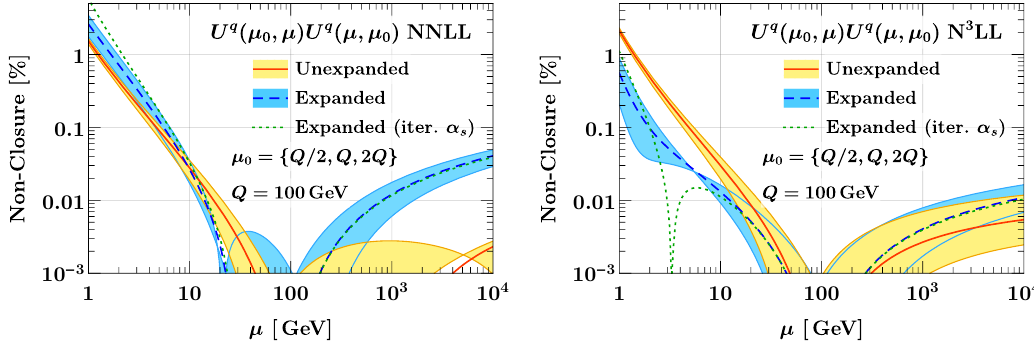
Figure 6 . Deviation from the closure condition U q ( (cid:22) 0 ; (cid:22) ) U q ( (cid:22); (cid:22) 0 ) = 1 at NNLL (left) and N 3 LL (right) for the unexpanded method (solid) and expanded method (dashed). The central lines are for (cid:22) 0 = Q , while the bands show the variation when changing (cid:22) 0 to Q= 2 and 2 Q . The green dotted line shows the result of using the iterative (cid:11) s ( (cid:22) 0 ) in the expanded kernels (for (cid:22) 0 = Q